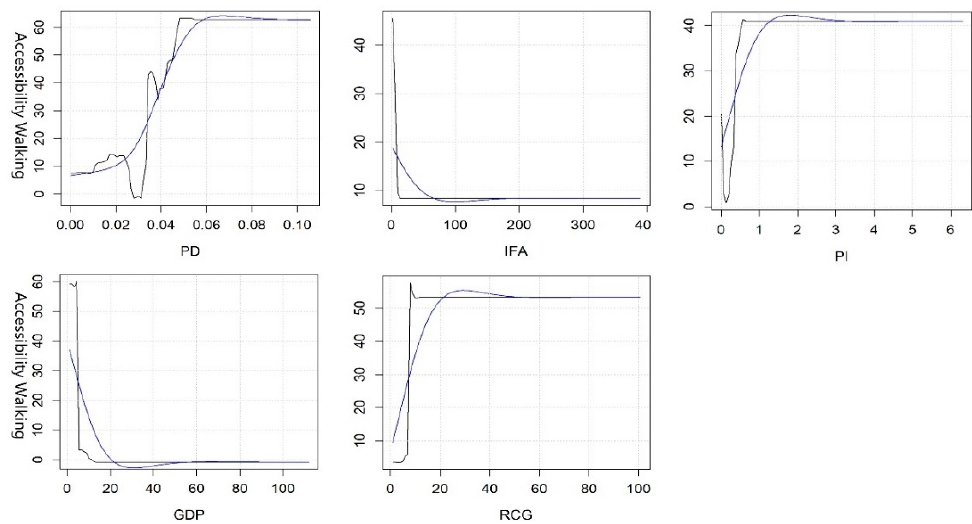
Figure 4. Nonlinear effects of various variables on the accessibility of PGSs by walking.